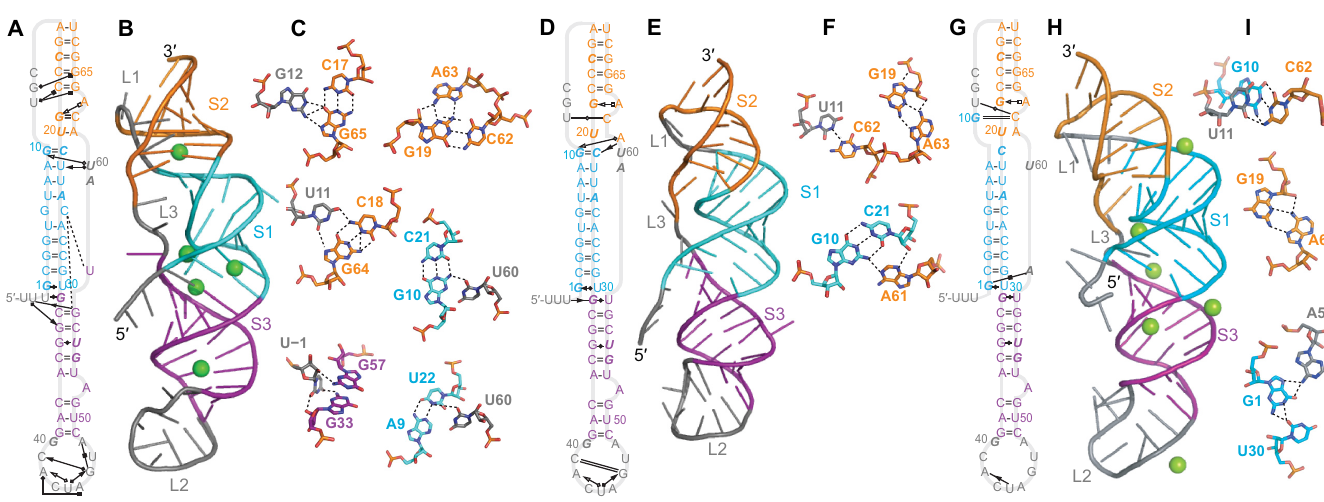
Fig 3. Representative structures from MD simulations of unthreaded models. (A–C) Structure from simulation of Fig 2F with Mg 2+ . (A) Secondary structure with tertiary contacts. Interactions indicated with the notation from Ref. (30). Bases shown in italic are protected against nuclease digestion in SARS-CoV-1. (B) Representative 3D structure of most populated cluster. Green spheres: Mg 2+ ions. (C) Close-up view of key tertiary contacts. (D–F) Same for simulation of Fig 2F without Mg 2+ , showing fewer tertiary contacts than with Mg 2+ in (A). (G–I) Same for simulation of Fig 2I with Mg 2+ .